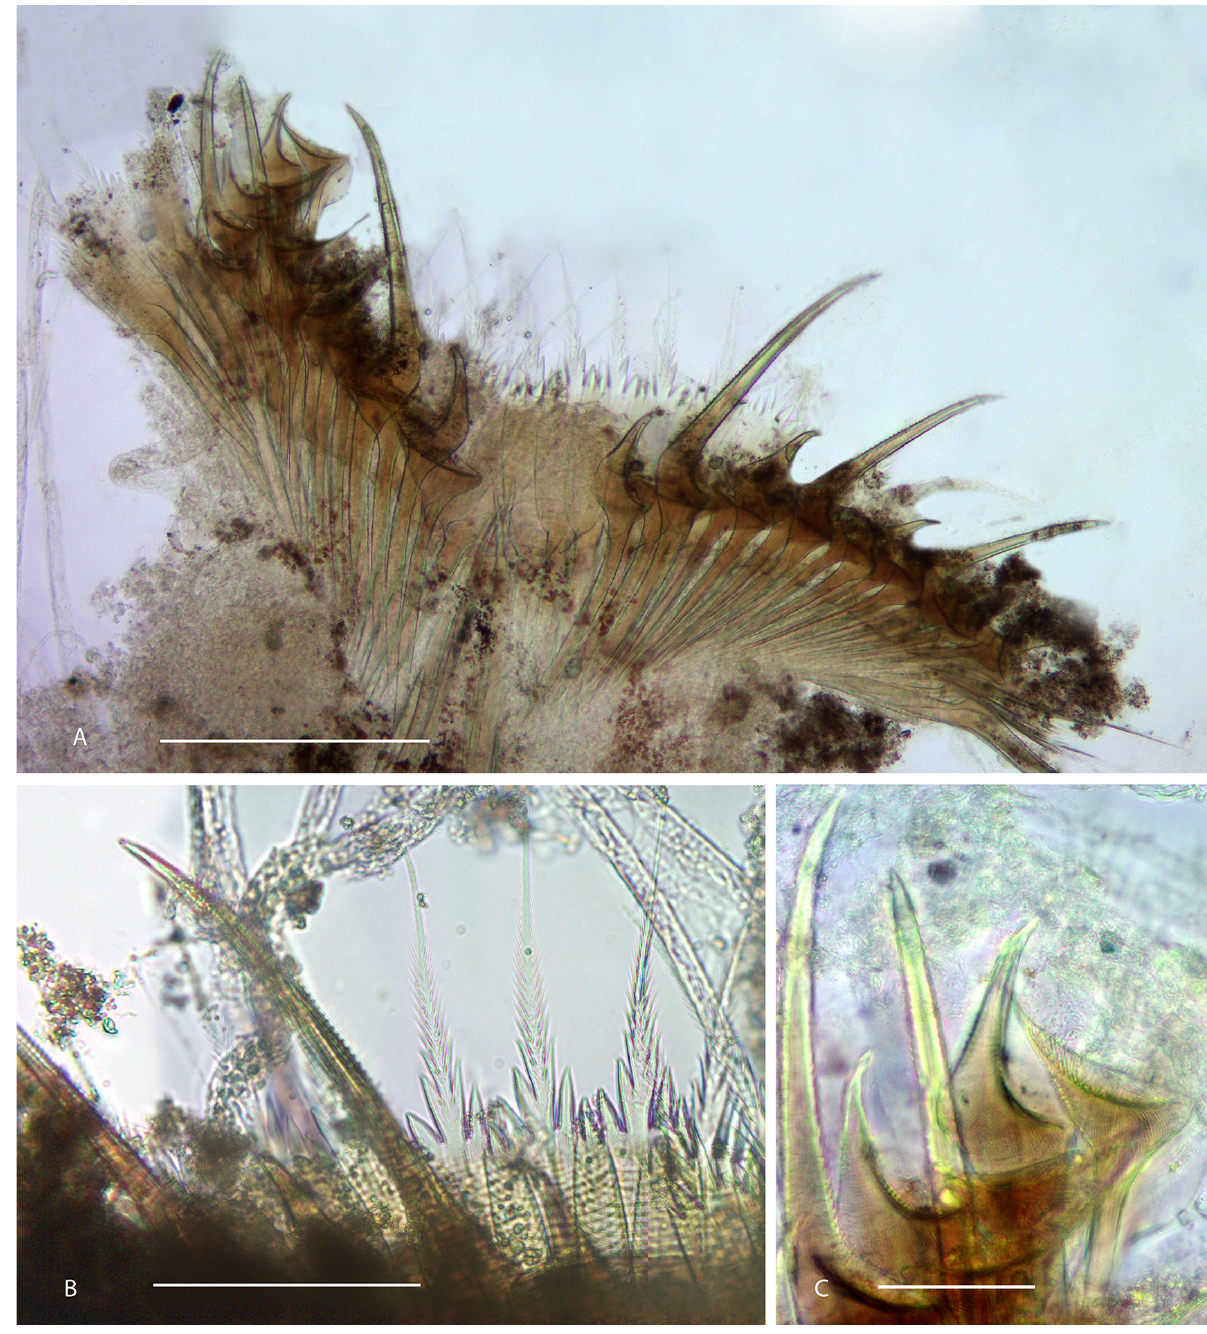
Fig. 11. – Sabellaria spinulosa. A, operculum from 40 days after juvenile metamorphosis showing the pattern of alternating long and short paleae (scale bar 300 m m); B, detail of the middle and outer paleae (scale bar 150 m m); C, detail of an inner palea (scale bar 100 m